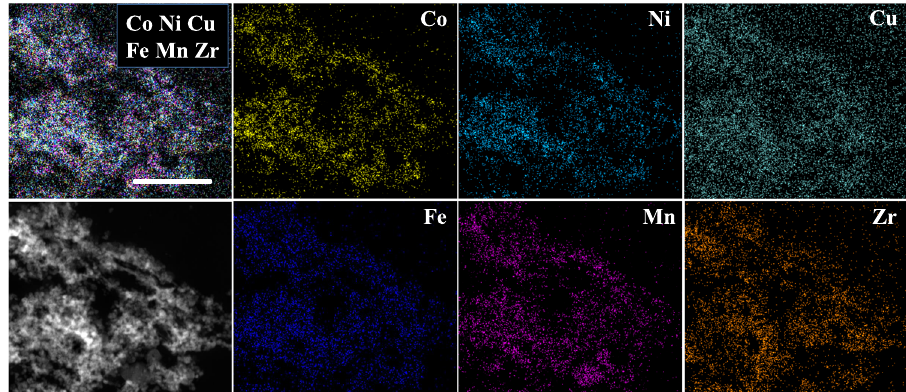
Fig. 4 The characterization of freshly made Zr 0.5 (NiFeCuMnCo) 0.5 O x . STEM - HAADF image and EDS elemental maps of Zr 0.5 (NiFeCuMnCo) 0.5 O x . Scale bar,